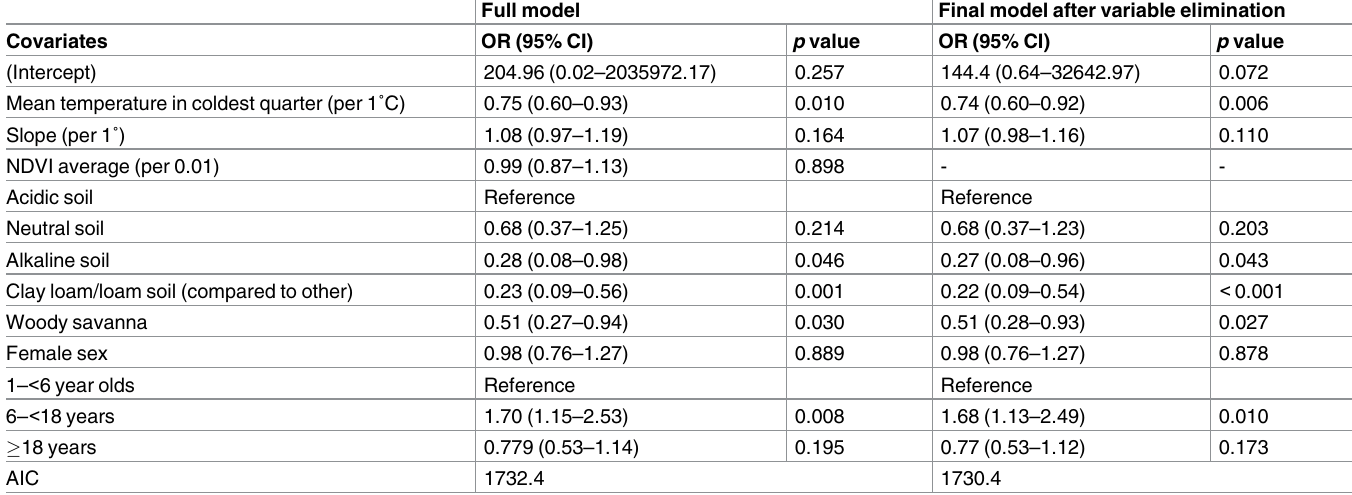
Table 3. Multivariable associations between environmental and demographic factors and the likelihood of A . lumbricoides infection, using multi- level mixed-effects logistic regression (n = 2,194).